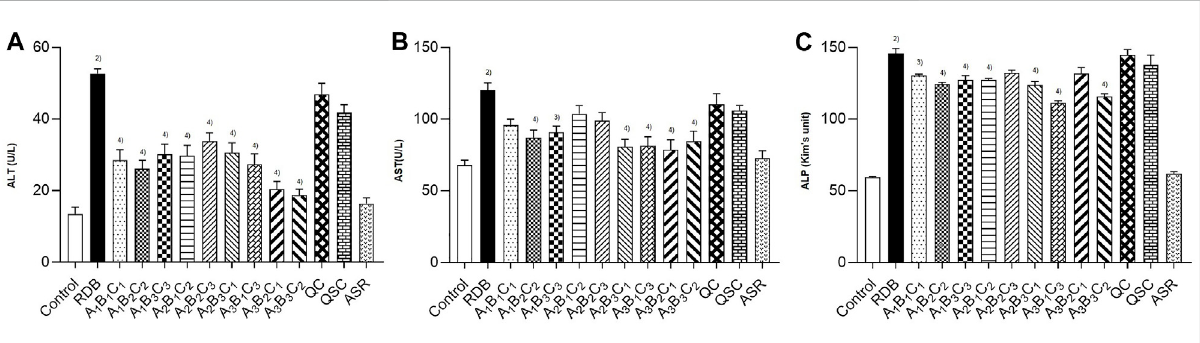
FIGURE 2 Processing with ASRinhibited thehepatotoxicityinducedbyRDBinmice. (A) SerumALTlevels. (B) SerumASTlevels. (C) SerumALP levels.Data were expressed as mean ± S.E.M., with 10 mice in each group. 1) p < 0.05, 2) p < 0.01, compared with the Control group, 3) p < 0.05, 4) p < 0.01, compared with the RDB group.